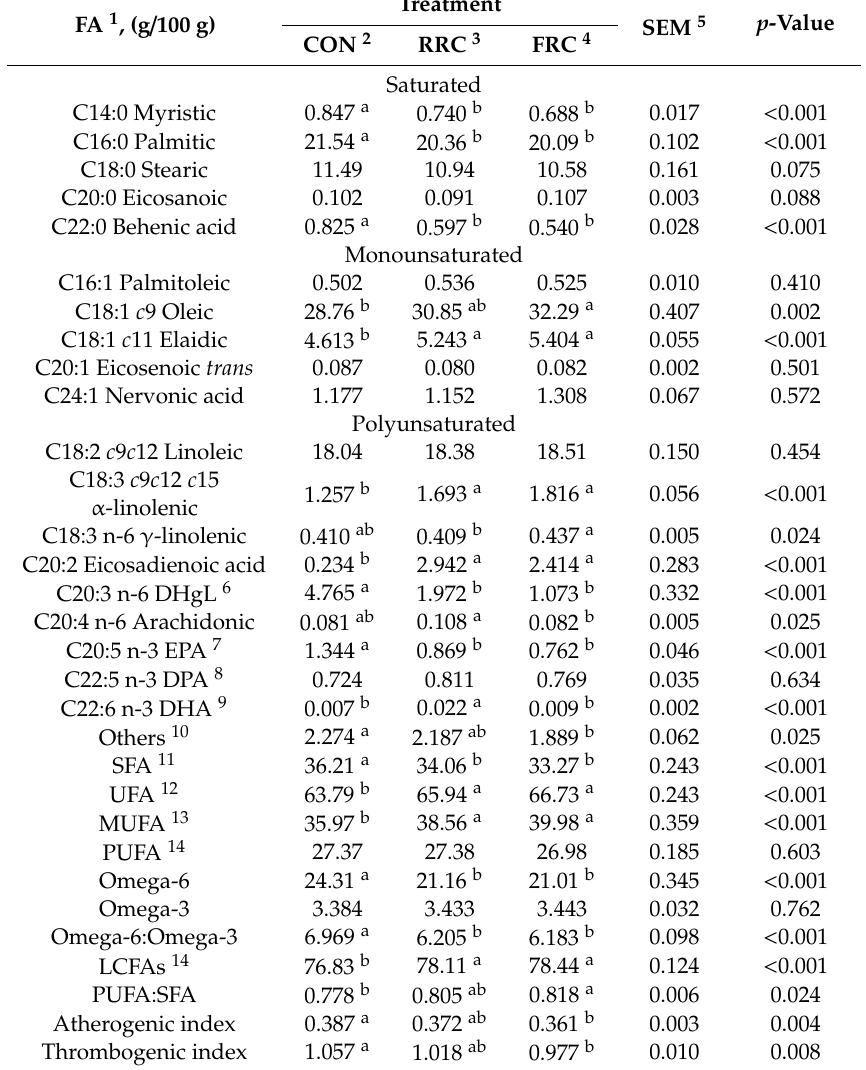
Table 9. E ff ect of diets containing raw rapeseed cake (RRC) and fermented rapeseed cake (FRC) on fatty acid profiles of chicken breast muscle (g / 100 g FA; 28-day-old birds); experiment 3. FA 1 , (g / 100